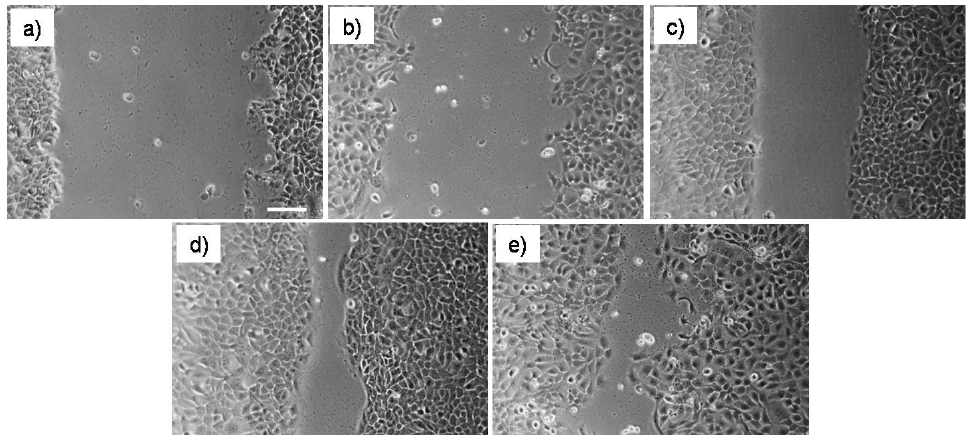
Figure 1. Cytotoxic effects of various Plg concentrations on L929 cells. * p ˂ 0.05 vs all samples.